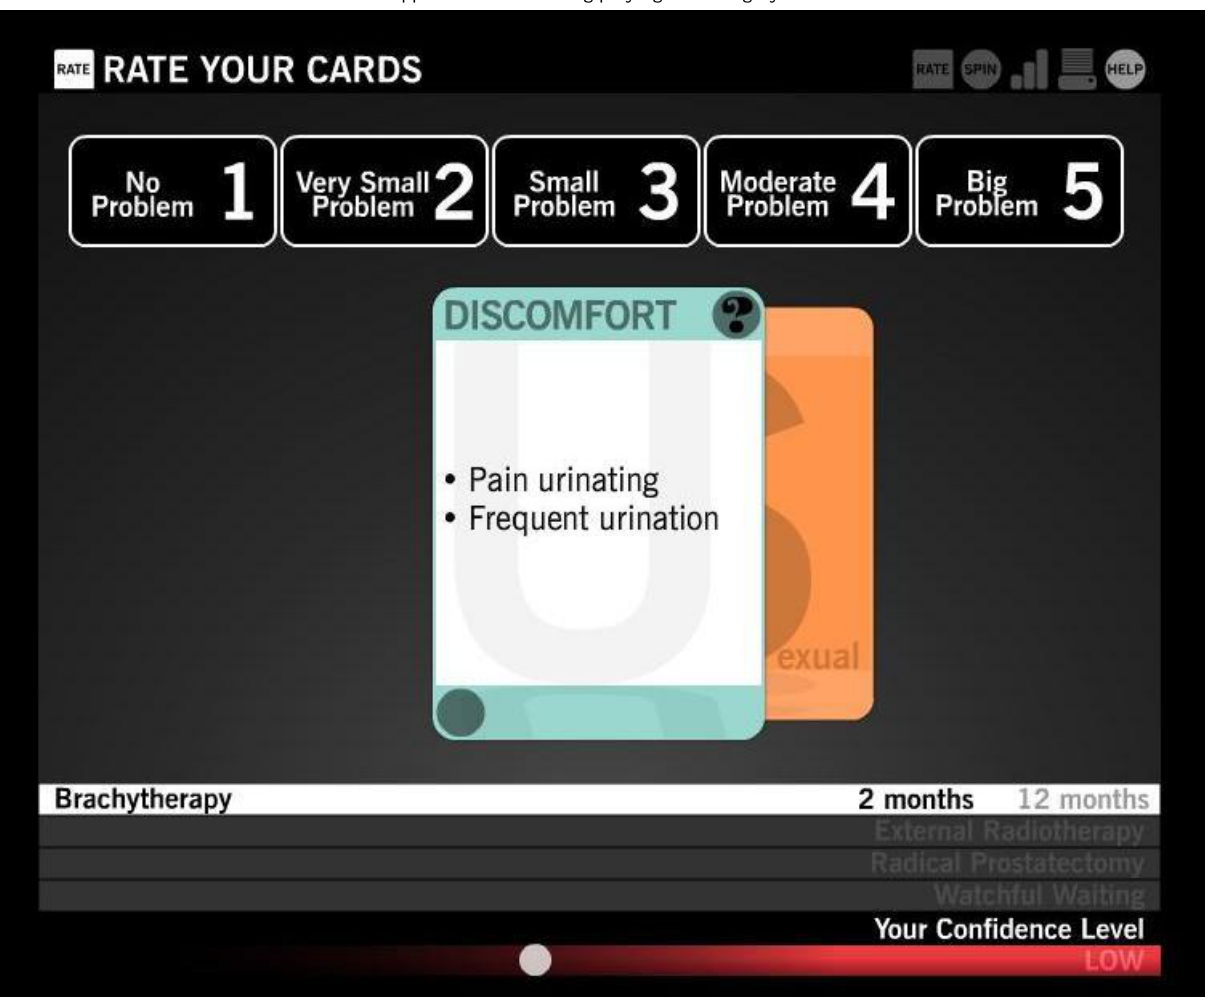
Figure 1. A side effect card in which side effects appear to the user using playing card